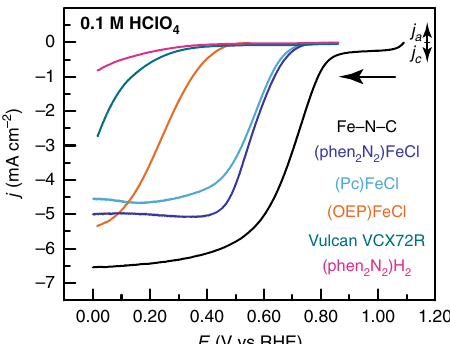
Fig. 7 Linear sweep ORR voltammograms of adsorbed catalysts. Glassy carbon disk electrodes modi fi ed with catalyst fi lms containing Fe-N-C (black), (phen 2 N 2 )FeCl (blue), (Pc)FeCl (aqua), (OEP)FeCl (orange), Vulcan carbon (green), and (phen 2 N 2 )H 2 (magenta) in O 2 -saturated 0.1 M HClO 4 electrolyte. Data were recorded at 5 mV s − 1 and 2000 rpm